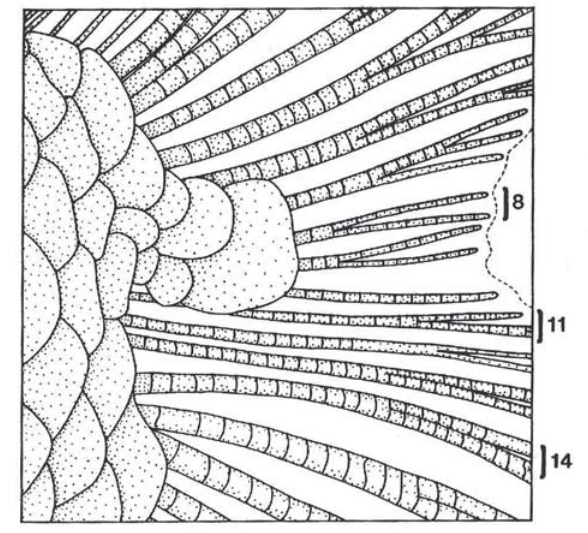
Fig. 24. Glandulocauda caerulea , adult male, USNM 326756, 39.4 mm SL; detail of caudal squamation in relation to principal caudal-fin rays 6-11. Lateral view, left side.